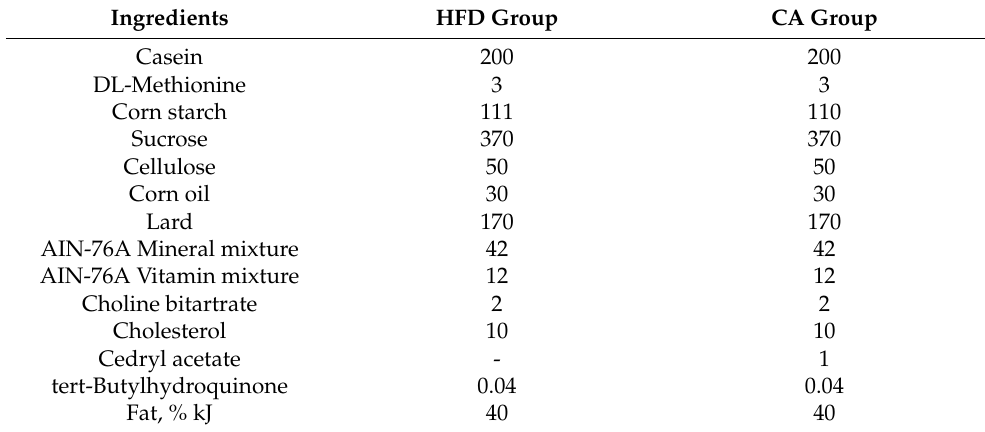
Table 1. Experimental diet composition